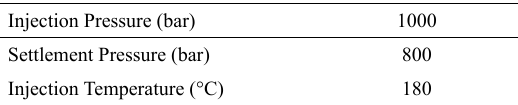
Table 3. Powder Injection Molding processing